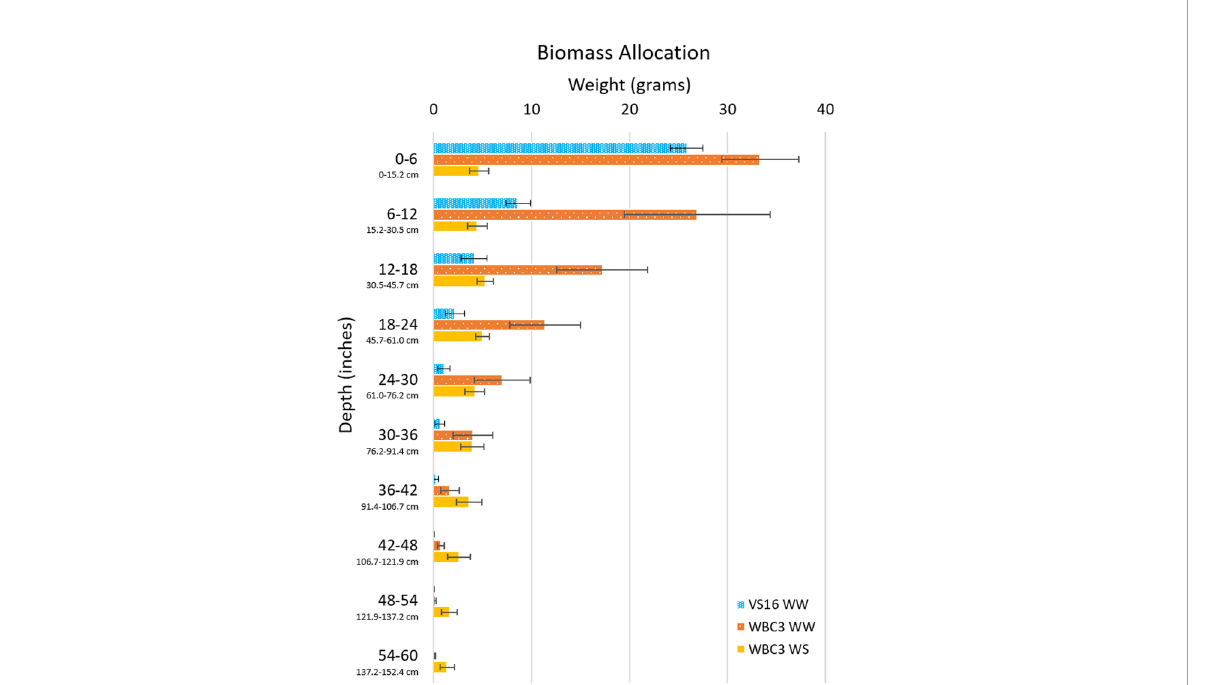
FIGURE 10 Biomass allocation by depth of switchgrass. Plot shows biomass measurements throughout the growth media pro fi le for VS16 well-watered (blue), WBC3 well-watered (orange), and WBC3 water stressed (yellow). Data values are means ± standard